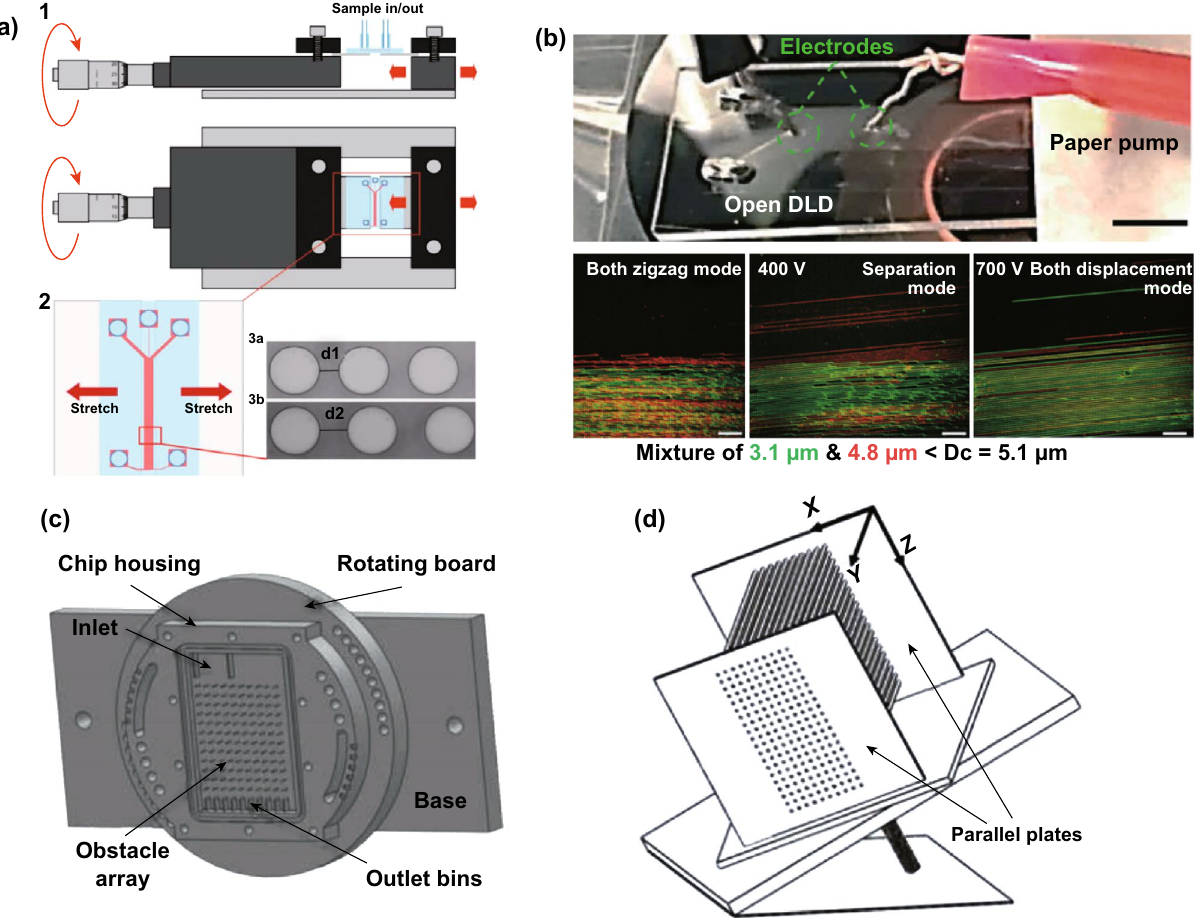
Fig. 10 Modulation of the critical diameter with external forces. a Tuning of critical diameter using elastomeric stretching to increase the gap size and change the critical diameter [68]. b Active tuning of the critical diameter using dielectrophoresis force [69]. c Centrifugal-driven DLD for modulation of forcing angles [70]. d Gravity-driven DLD for modulation of forcing angles [54]. Figure panels reproduced from Ref. [68] with permission from the Royal Society of Chemistry, copyright 2008, Ref. [69] with permission from the Royal Society of Chemistry (CC BY 2017), Ref. [70] with permission from Springer Nature, copyright 2016, Ref. [54] with permission from Springer Nature (CC BY